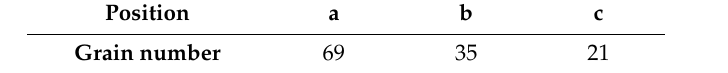
Figure 5. Diagrams and inverse pole figure at different heights with width 10 mm. ( a ) Height 2mm; ( b ) Height 15mm; and ( c ) Height 25mm. Table 3. Grain numbers at different heights of grain selector.